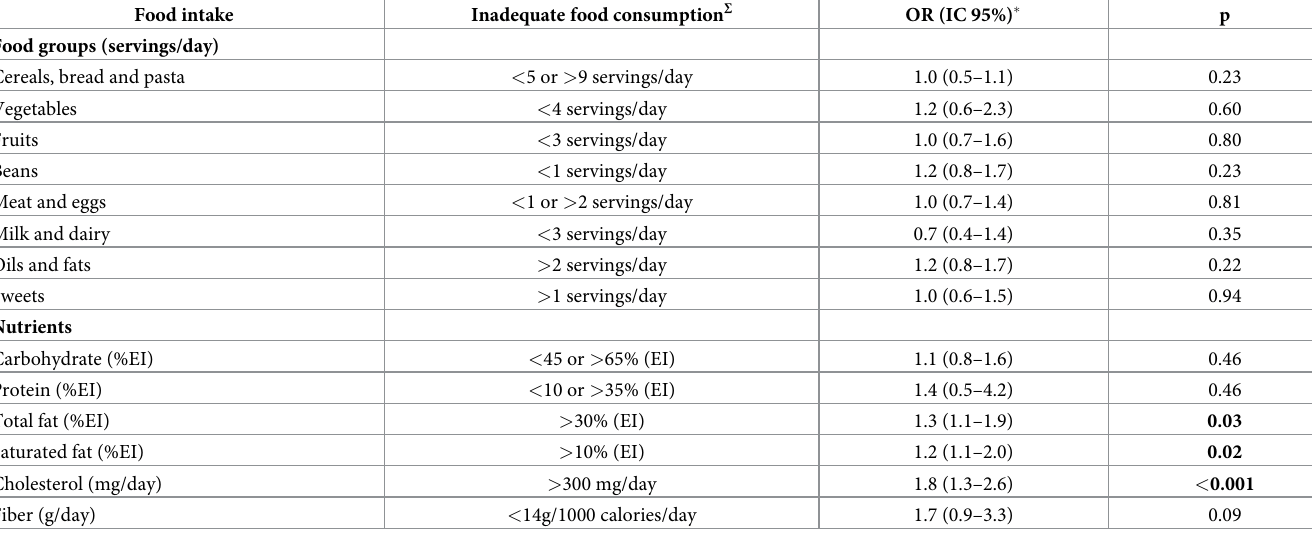
Table 3. Odds ratio (OR) for inadequate food consumption according to presence ( > 1h) or absence of social jetlag ( � 1h –reference group) (n =